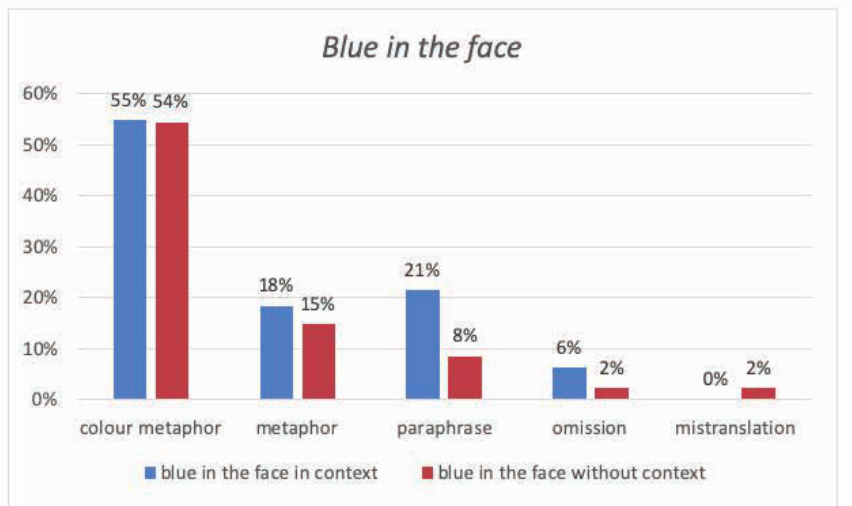
Figure 2: Translation strategies used for translating the colour metaphor blue in the face in context and without